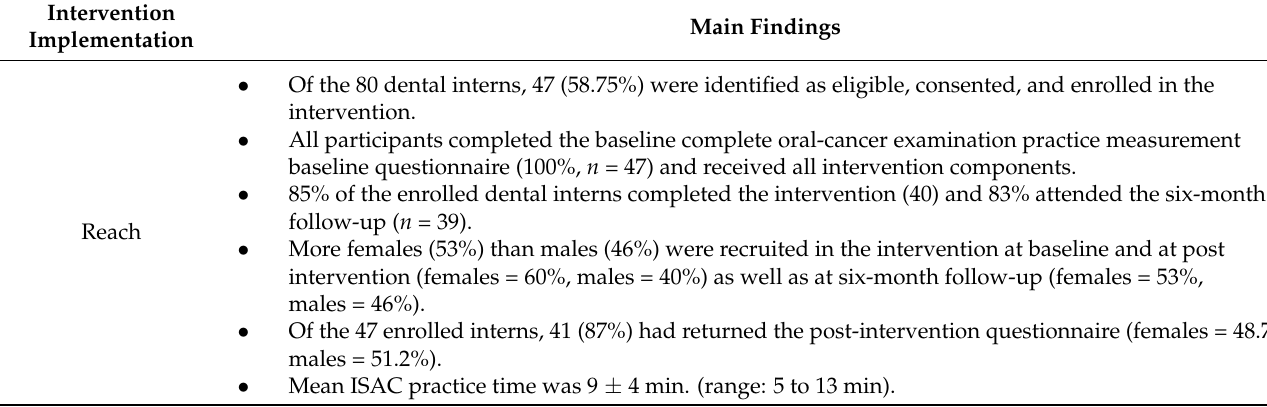
Table 4. Summary of the main findings of the ISAC process